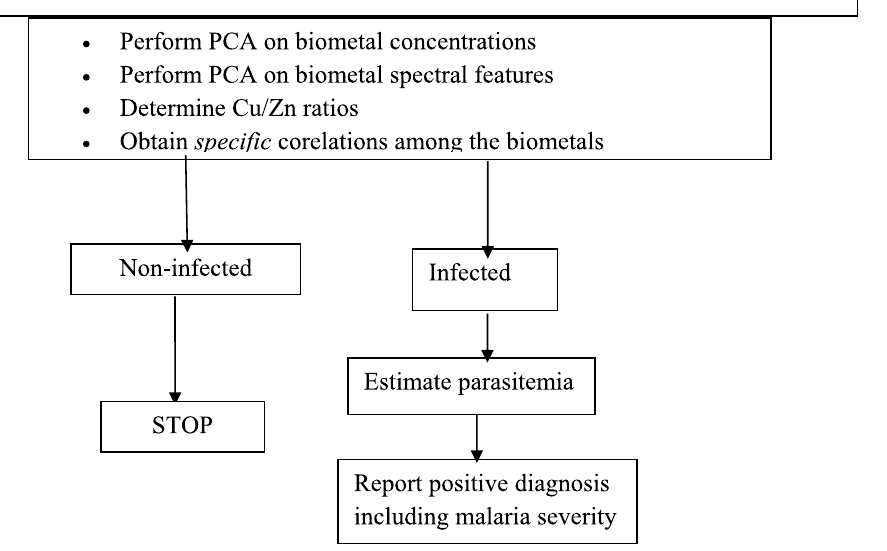
Figure 8. Flow chart of malaria diagnostics by chemometric peak-free